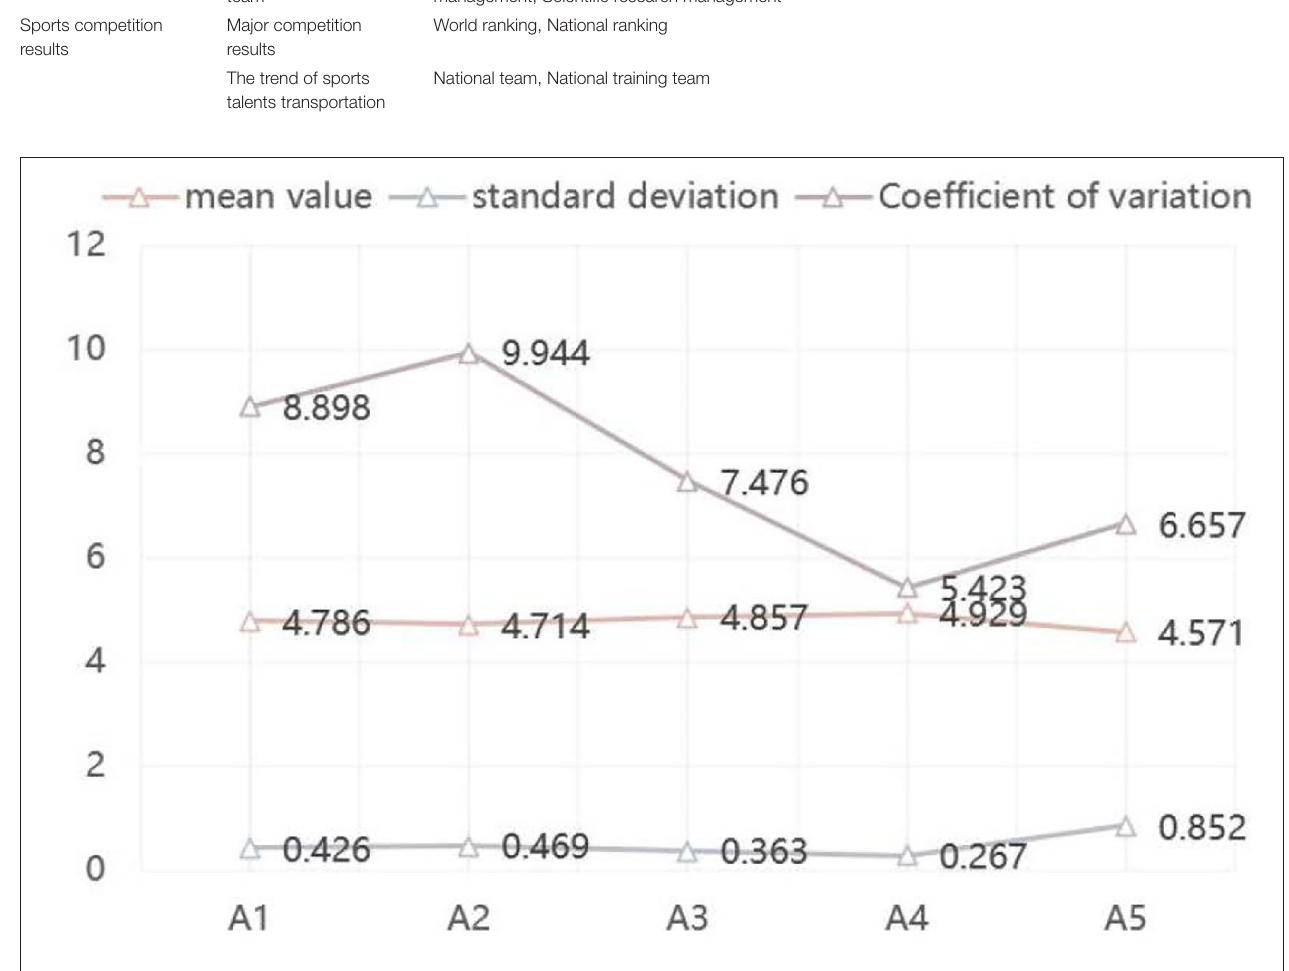
FIGURE 2 | List of survey results of the first index experts.